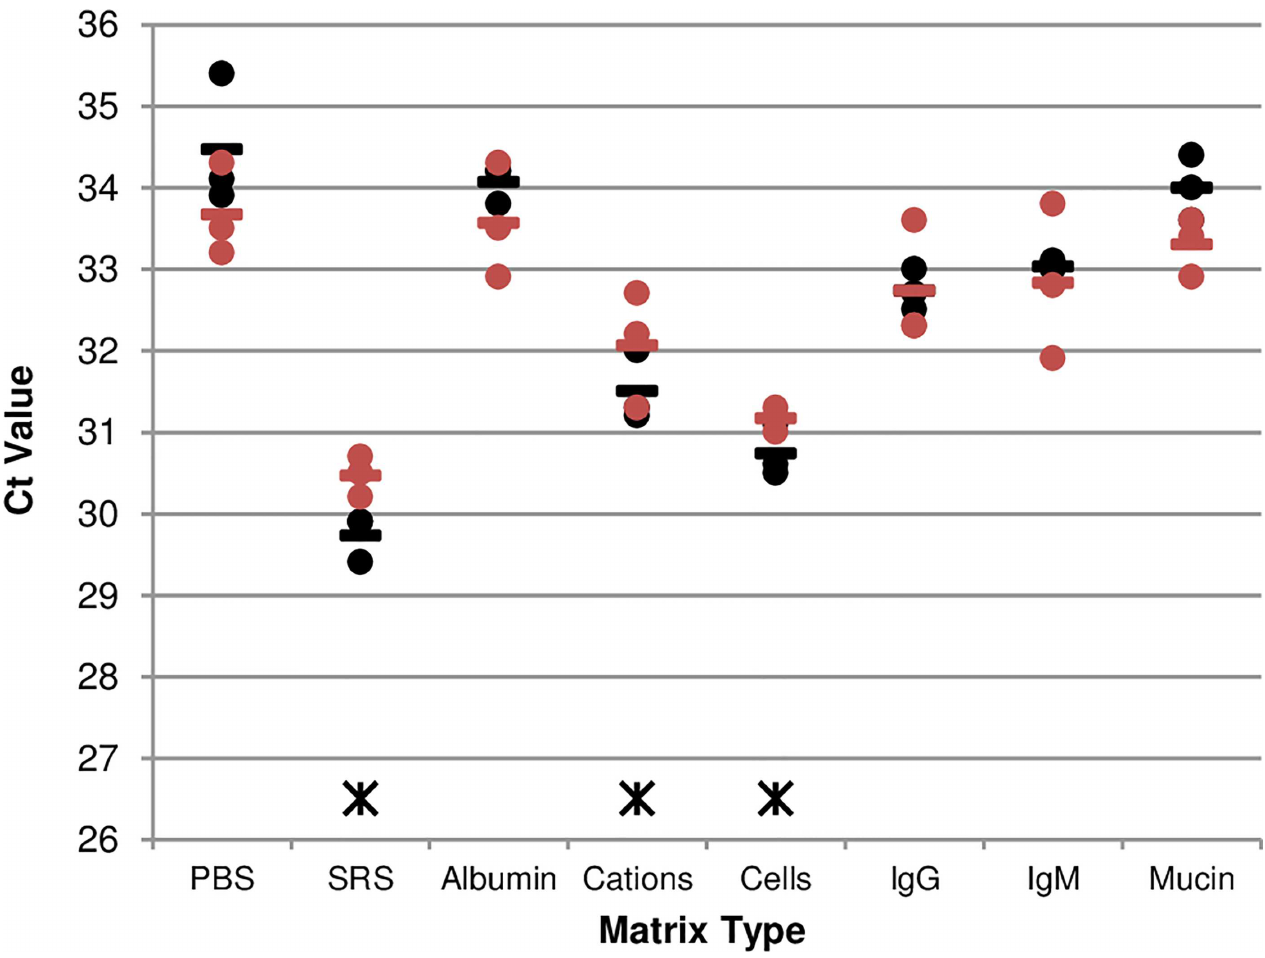
Fig 1. The results of testing each component’s effect on the Liat assay. H1N1pdmwas diluted in each of the matrices containing each of the componentsand tested in triplicate in the Liat assay. The experimentwas performed twice with the repeats shown in black and red. Each matrix was comparedto PBS using the t-test. Bars indicatethe mean of the three replicatesfor each repeat. Asterisks indicate a significantdifference from PBS